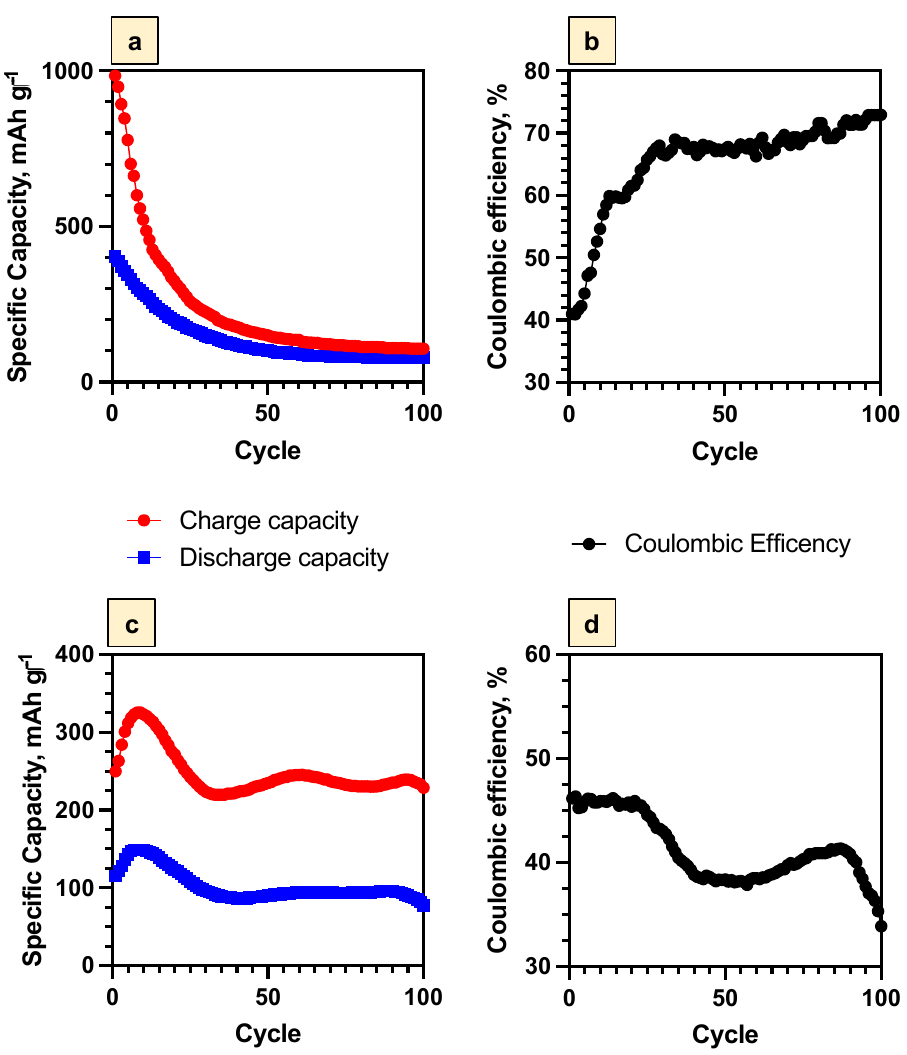
Figure 10. Galvanostatic charge/discharge cycling performances of Bi 2 Se 3 thin films in 5M LiNO 3 at 1 C: ( a )—cycling performance for the SEI layer ( − 1.0 V ÷ 1.3 V), ( b )—Coulombic efficiency for the SEI layer ( − 1.0 V ÷ 1.3 V), ( c )—cycling performance for the Bi 2 O 3 layer ( − 1.0 V ÷ 0.5 V), ( d )—Coulombic efficiency for the Bi 2 O 3 layer ( − 1.0 V ÷ 0.5 V).